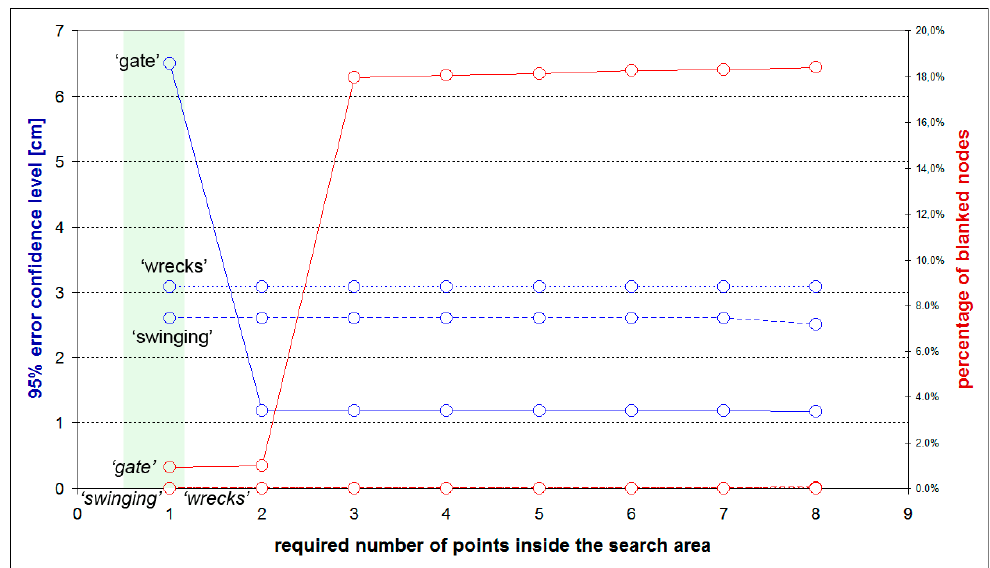
Figure 7. Results for all three tested surfaces with different number of minimum points required inside the search radius.